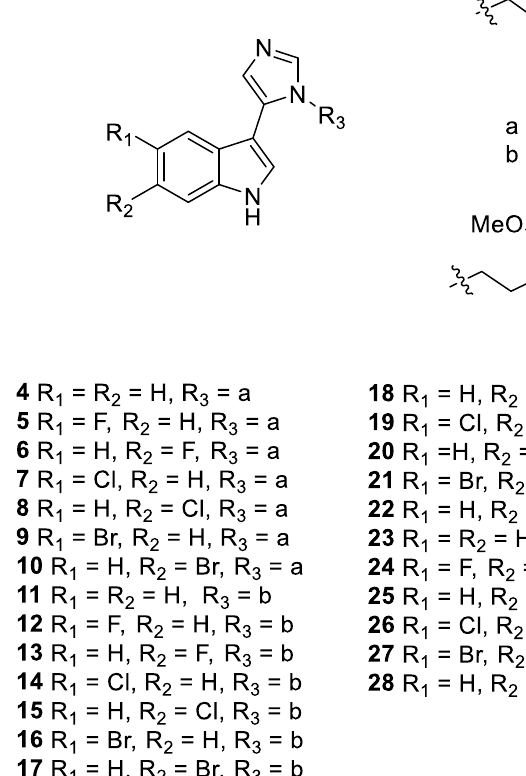
Antibiotics 2022 , 11 , x FOR PEER REVIEW